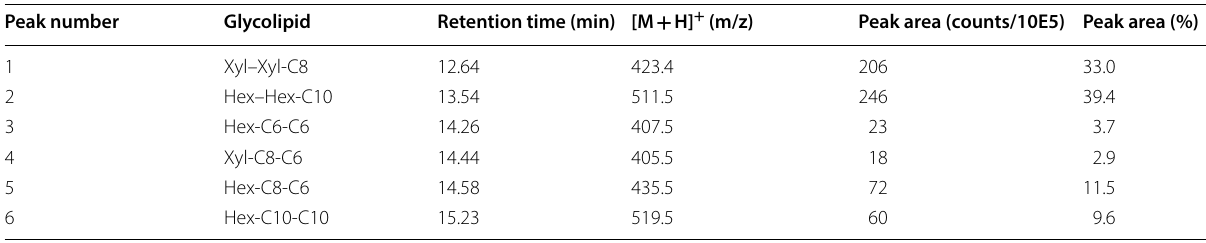
Xyl stands for a xylose molecule whereas Hex stands for a Glucose or a Galactose molecule; Cn stands for an alkane fatty acid molecule with n carbons in carbon chain length